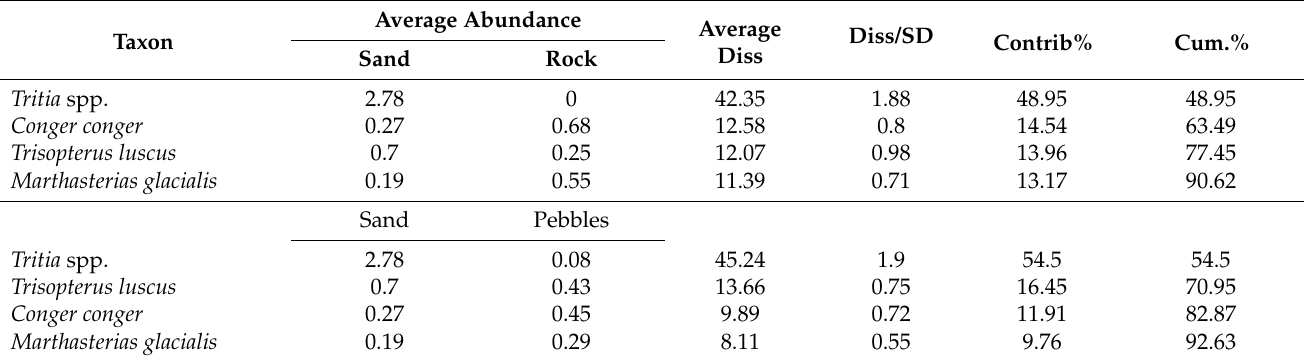
Table 4. SIMPER analysis results for the top contributors of the dissimilarity of scavenging megafaunal assemblages between habitats as determined by PERMANOVA based on the four root density data.